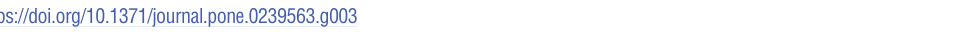
PLOS ONE | https://doi.org/10.1371/journal.pone.0239563 October 8,